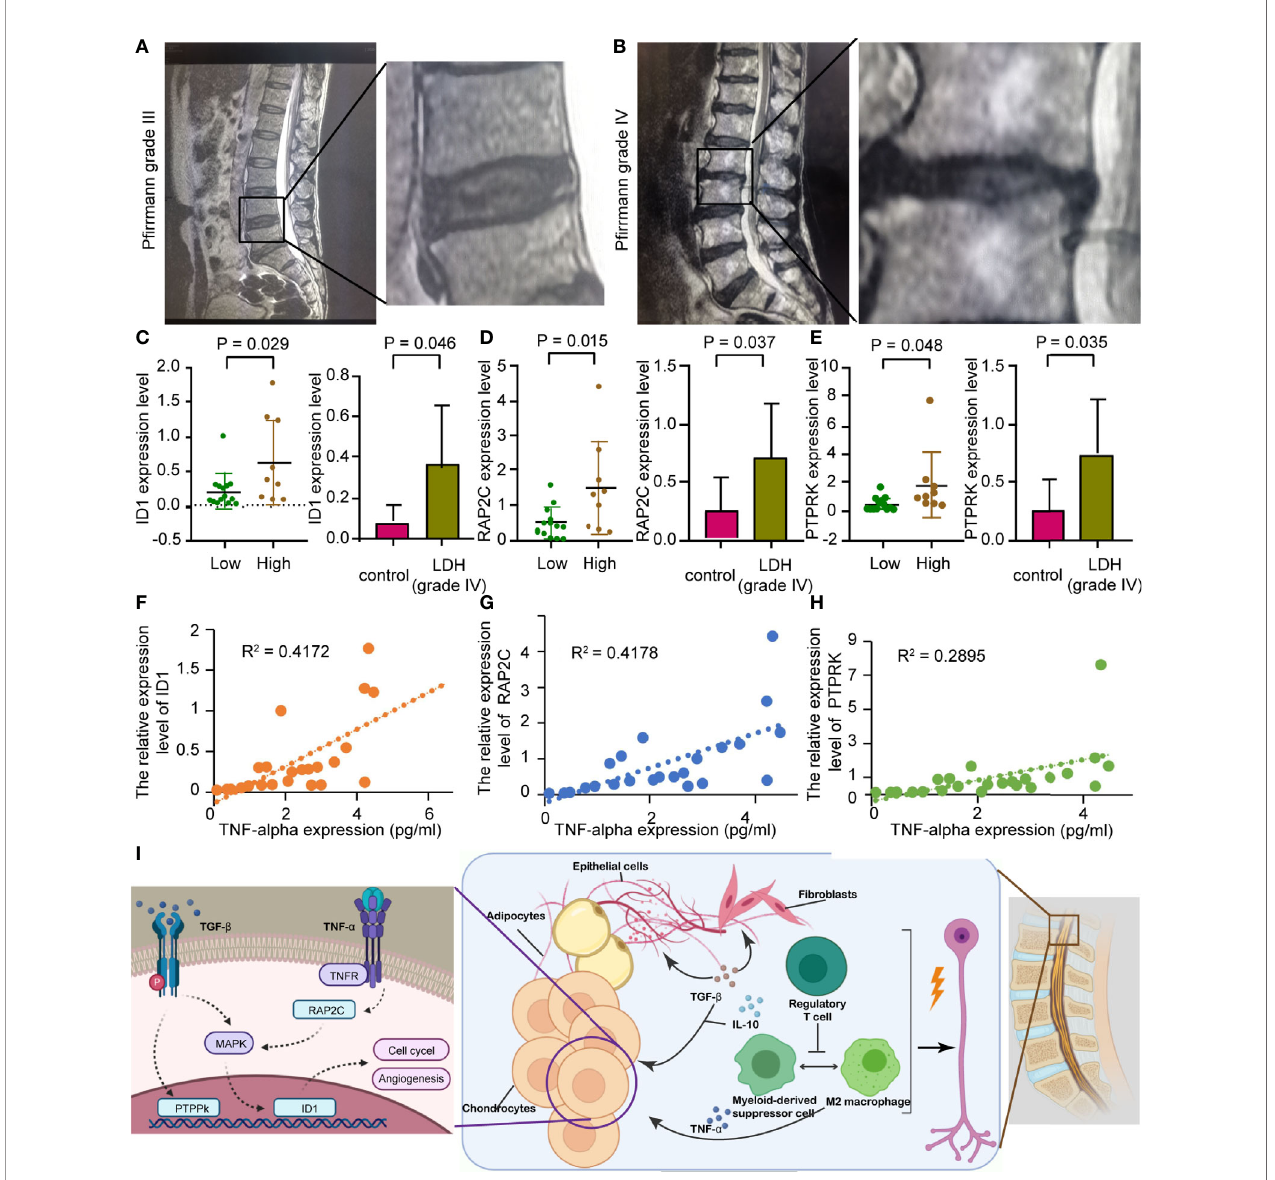
FIGURE 8 | Prospective clinical experiment con fi rms the bioinformatic results. (A, B) The MRI image shows lumbar disc herniation in patients from different groups which are divided by P fi rrmann grades I-III or IV. (C, E) Comparison of preoperative hub gene expression levels. The box plots on the right show hub genes expression in in vertebral disc tissue from different groups, divided by the P fi rrmann disc grade; The left honeycomb map show hub genes expression levels in the high and low immunity groups, coffee color represent high immunity group and green represent low immunity group. (C) ID1 , (D) RAP2C , (E) PTPRK. (F) Schematic showing that the extrusion of the nucleus pulposus in a degenerating intervertebral disc could cause multiple in fl ammatory responses, resulting in radicular pain. (G – I) Correlation between TNF- a level assessed by ELISA and hub genes expression, as previously described. R represents Pearson ’ s correlation coef fi cient. (G) ID1 , (H) RAP2C , (I)